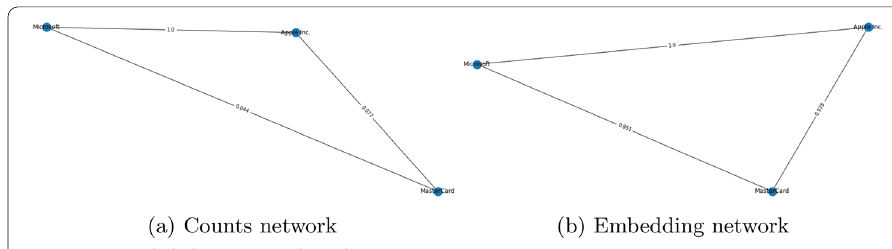
Fig. 7 Business links between 3 selected